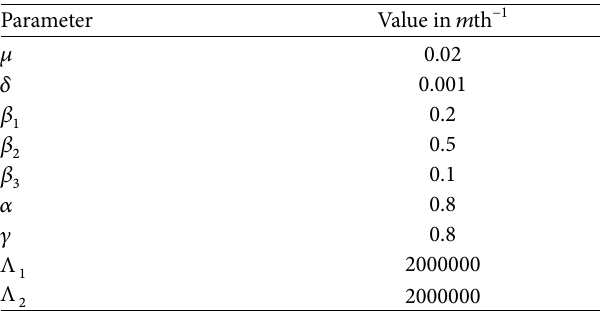
Figure 1: The evolution of the number of diabetics with and without complications without Table 1: Parameter values used in numerical simulation.